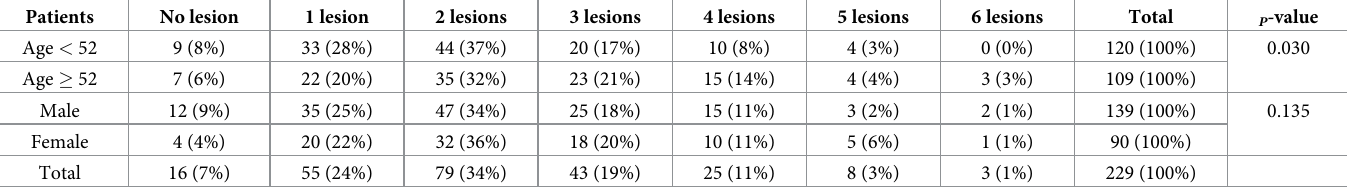
Table 2. Number of lesions per patient by age and sex (n = 229).